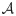
Conceptual illustration of conditions with varying amounts of similarity between data from domains T and U, as indicated with the green and blue circles.Previous research [8] showed that the amount of overlap between domains, which can be measured using the proxy A-distance, influences the performance of a consecutive supervised classification task. The advantage of the DRC over the proxy A-distance, is that the DRC has the potential to determine when domains are similar enough (i.e. domain T is representative of domain U) for a sufficient performance of a consecutive supervised classification task.